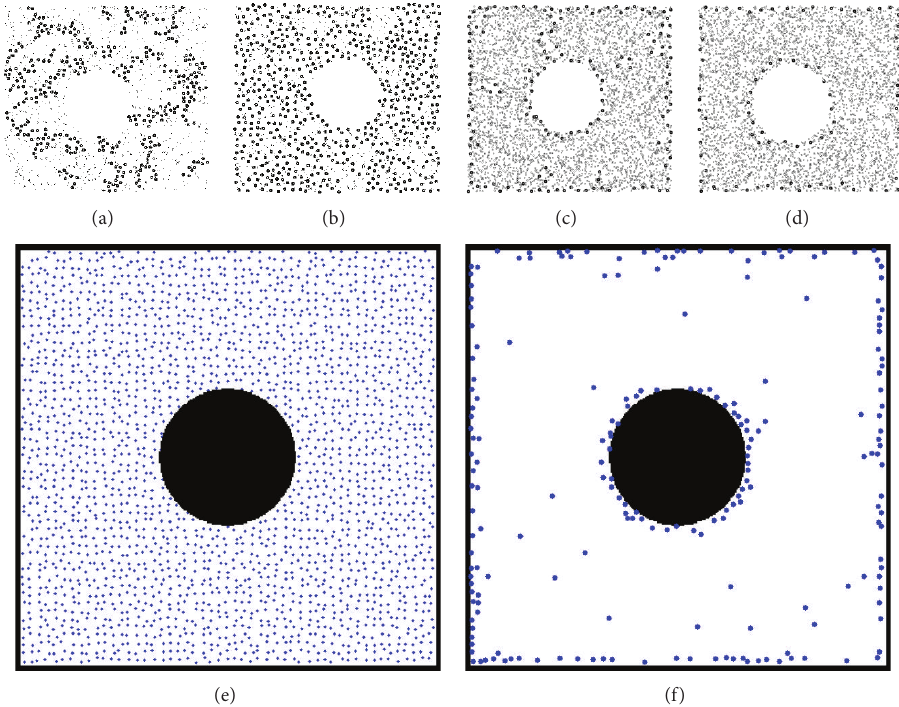
Figure 12: A comparison between algorithms. (a–d) Funke’s algorithm with average degree at 5 in (a), 10 in (b), 18 in (c), and 39 in (d). The black dots are identified as boundary nodes, while gray ones are inner nodes. (e)–(f) Our algorithm with average degree at